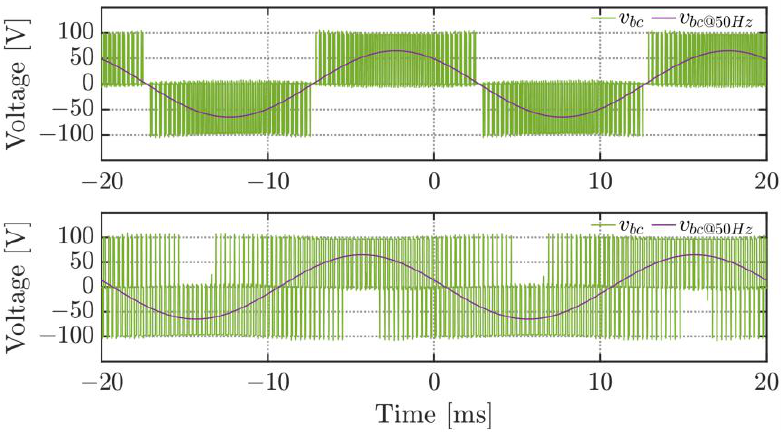
Figure 15. Experimental line-to-line voltages (green) and their fundamental components (violet) in case of single ( top ) and three interleaved ( bottom ) carriers at modulation m = 0.4 and a switching frequency of 3.6 kHz.